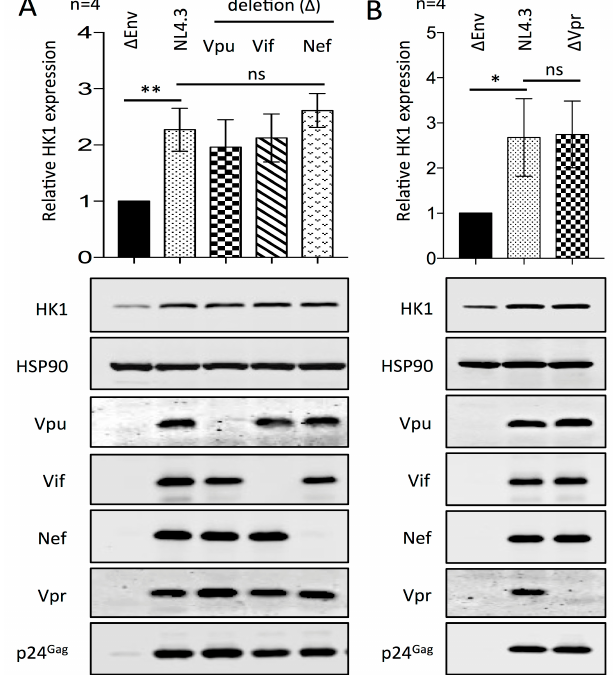
Figure 5. HIV-1 accessory proteins are not required for the upregulation of HK1 in CD4+ T cells infected with HIV-1 NL4.3. ( a ) Western blotting analysis of CD4+ T cells infected with HIV-1 wt NL4.3 or mutant viruses that have the Env, Vpu, Vif, or Nef genes deleted. Quantified data, that are shown above in a representative Western blot, are relative to HSP90 expression and normalized to the amounts present in cells treated with Δ Env NL4.3, for four donors; ( b ) Western blotting analysis of CD4+ T cells infected with HIV-1 wt NL4.3 or mutant viruses that have the Env or Vpr genes deleted. Quantified data, that are shown above in a representative Western blot, are relative to HSP90 expression and normalized to the amounts present in cells treated with Δ Env NL4.3, for four donors. Significance is indicated by * p ≤ 0.05 and ** p ≤ 0.01.